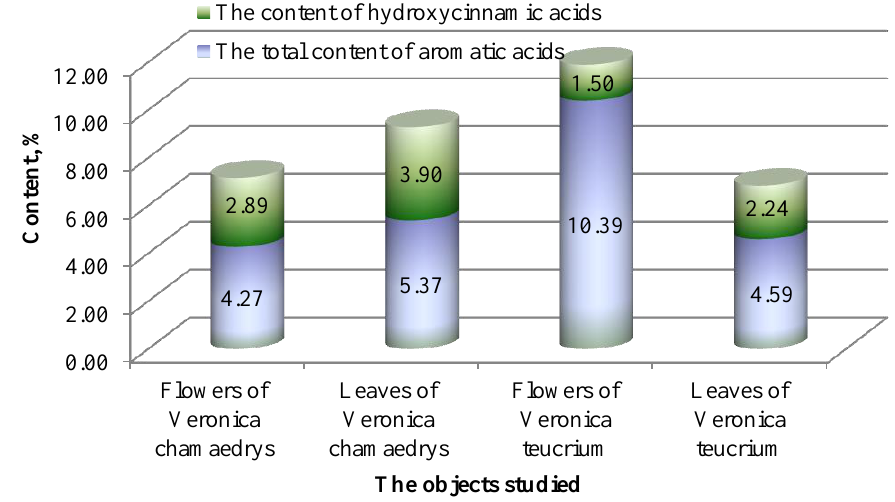
Fig. 7. The content of hydroxycinnamic acids in the composition of aromatic acids in the flowers and leaves of Veronica chamaedrys and in the flowers and leaves of Veronica teucrium In the leaves of Veronica chamaedrys the